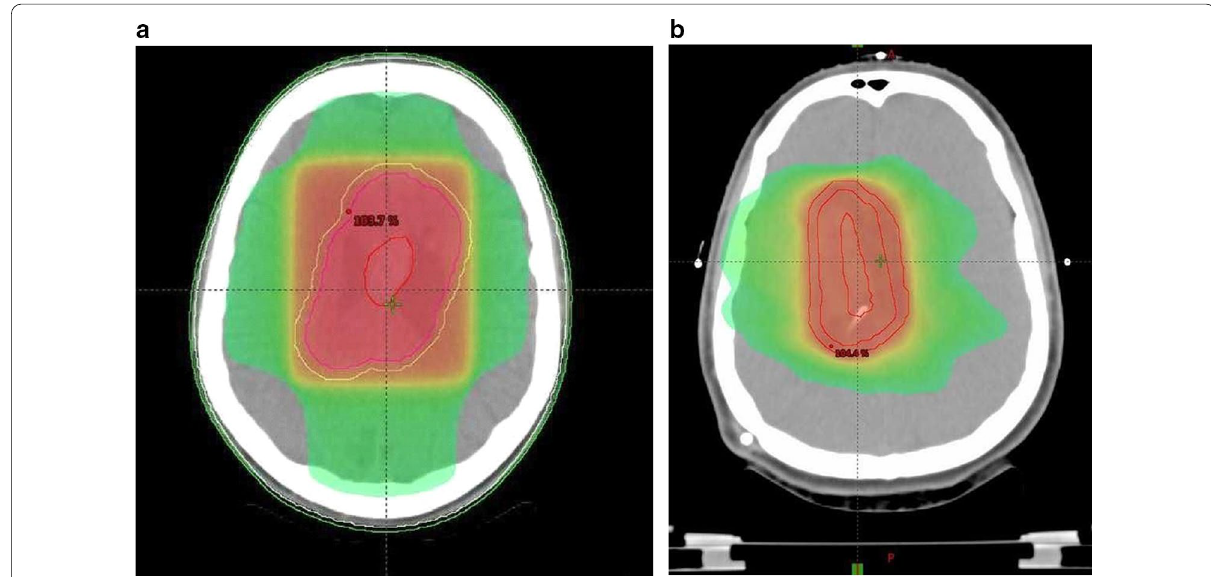
Fig. 4 Radiotherapy plan for cases of central neurocytoma. a Radiotherapy plan of three‑dimensional radiotherapy treatment for a post‑operative case. b Shows the radiotherapy plan of rapid arc radiotherapy treatment in a case of recurrent neurocytoma post 3rd